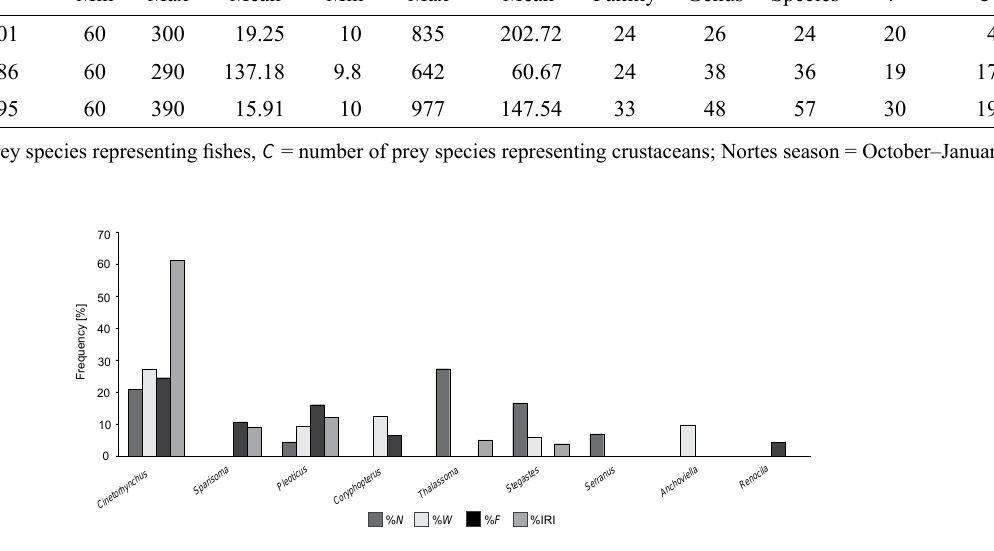
Fig. 6. Diet composition of red lionfi sh, Pterois volitans , by genus during the dry season; % N = percentage by number, % W = percentage by weight, % F = frequency of occurrence, %IRI = index of relative importance %IRI